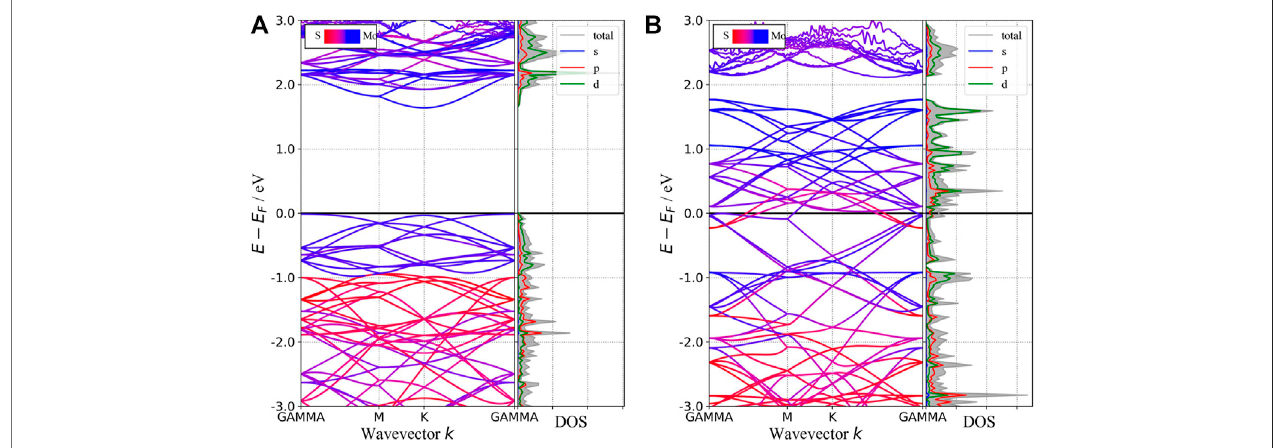
FIGURE 2 | Band structures and pDOS of 2H-MoS 2 (A) and 1T-MoS 2 (B) . The blue (red) curves are mainly contributed by atom Mo (S) in the band structure. The shadow areainthepDOSreferstothetotalDOS, andthesolidlines ofdifferentcolorsrefertotheprojectionondifferentorbitalsindicatedbythelegendinsidethe fi gure.